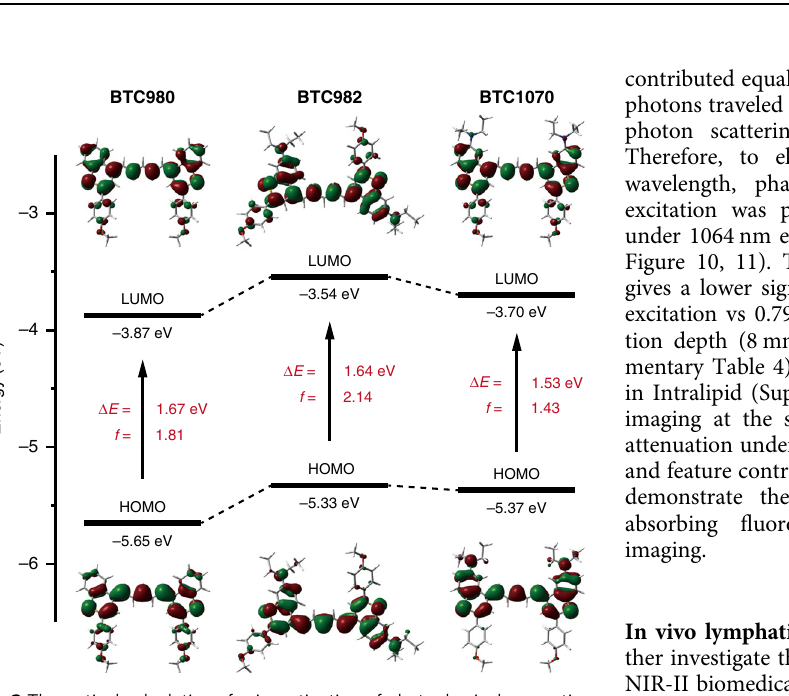
Fig. 2 Theoretical calculations for investigation of photophysical properties. Comparison of the HOMO and LUMO energy levels, S 0 – S 1 excitation energies, and oscillator strengths for BTC980, BTC982, and BTC1070, based on TDDFT calculations at the B3LYP/6 – 311 G(d,p) level